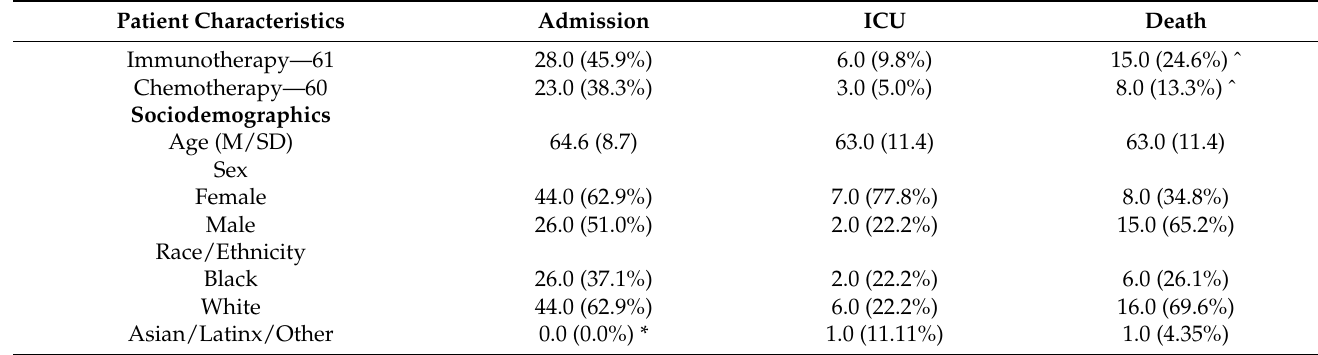
Table 4. Risk factors of admission, ICU and mortality, COVID-19 infection ( n =